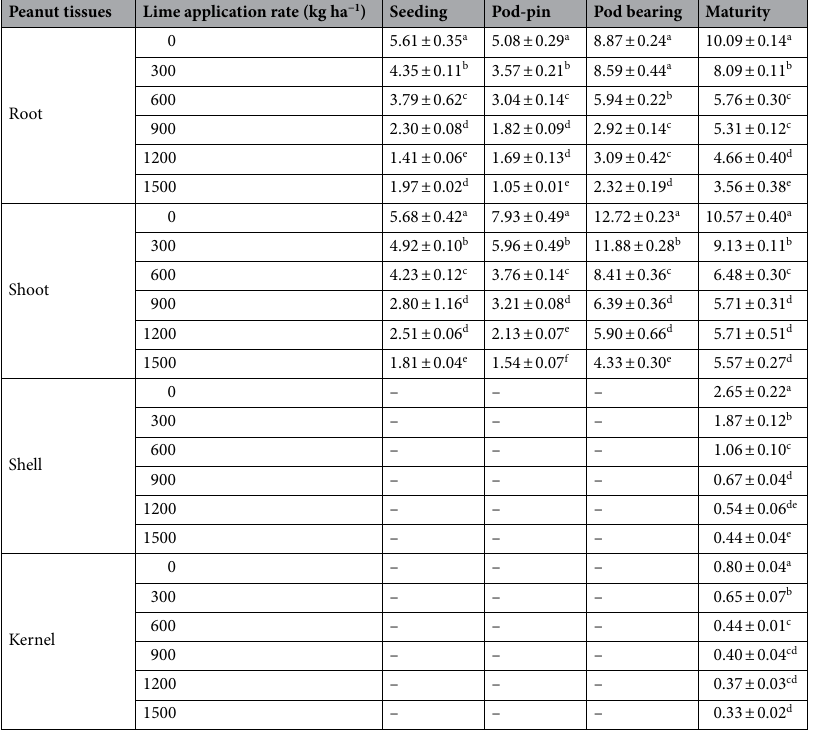
Table 4. Effects of slaked lime applications on the bioconcentration factors (BCF) of peanut tissues in the different growth stages. BCF = Con tissues /Con soil . Values are means (± SD) of three replicates. Different lowercase letters indicate a significant difference ( p < 0.05) among six treatments of slaked lime within the same growth stage.